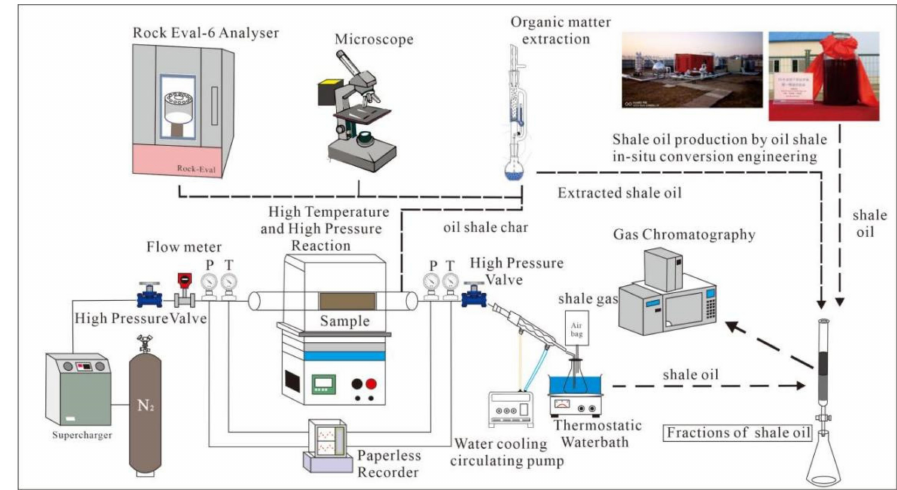
Figure 1. Experiment flow